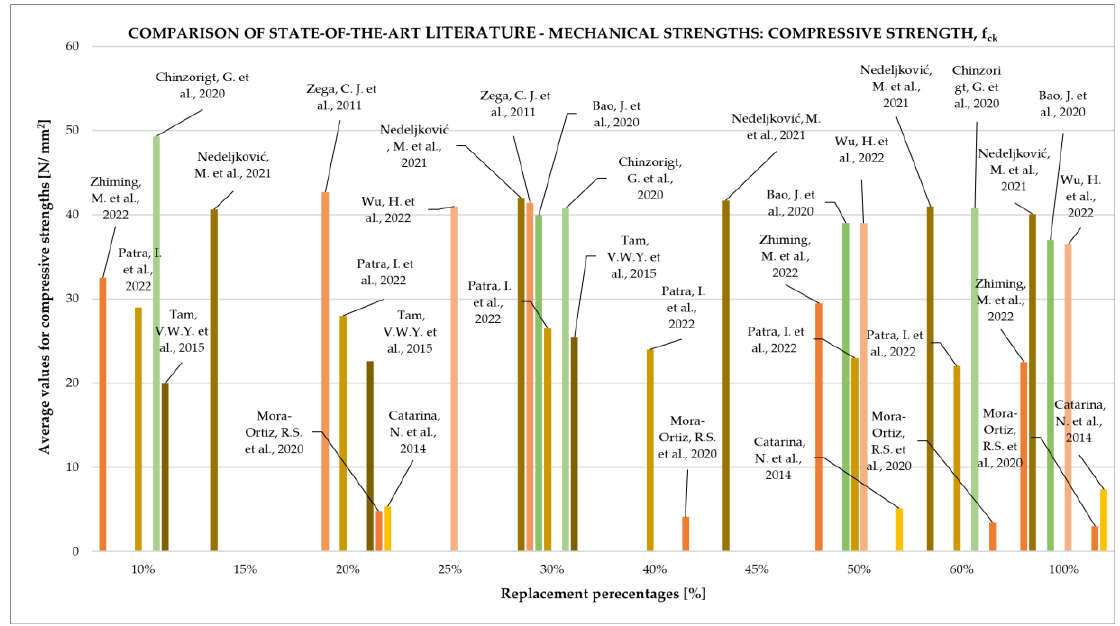
Figure 2. Comparative analysis of compressive strengths according to the studies reviewed [3,4,8 –